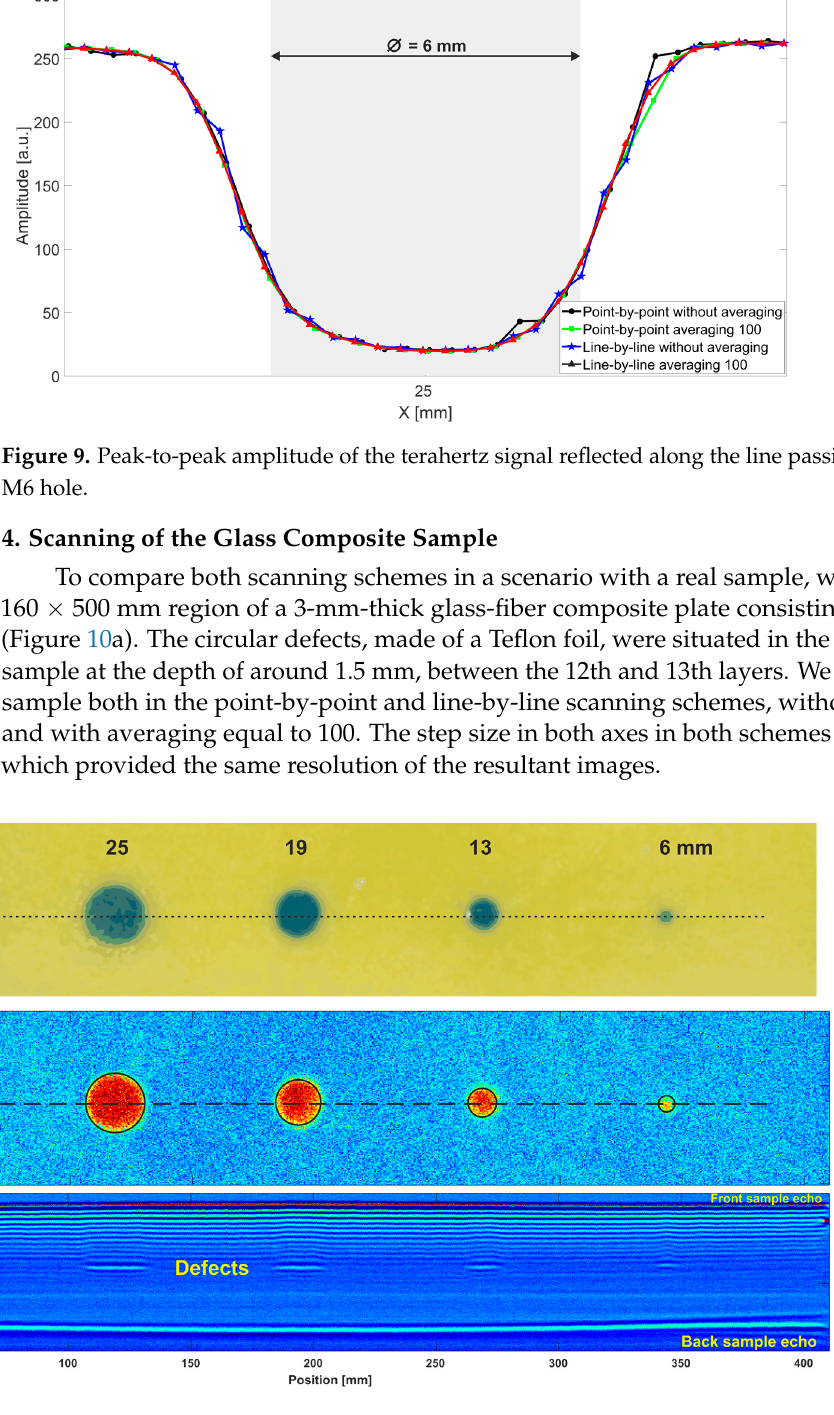
9 of 12 Table 2. Horizontal and vertical means for different scanning schemes. Mean Distances between the Centers of Adjacent Circles